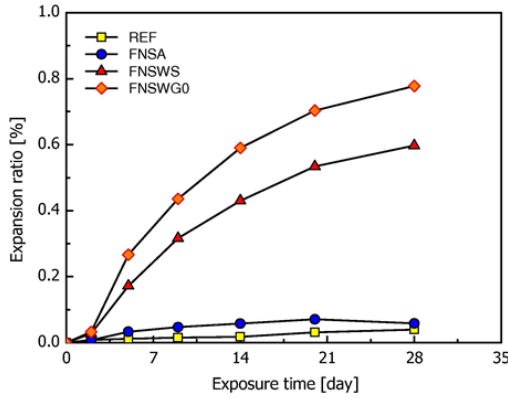
Figure 14. The expansion ratio of mortar containing EFS [127].